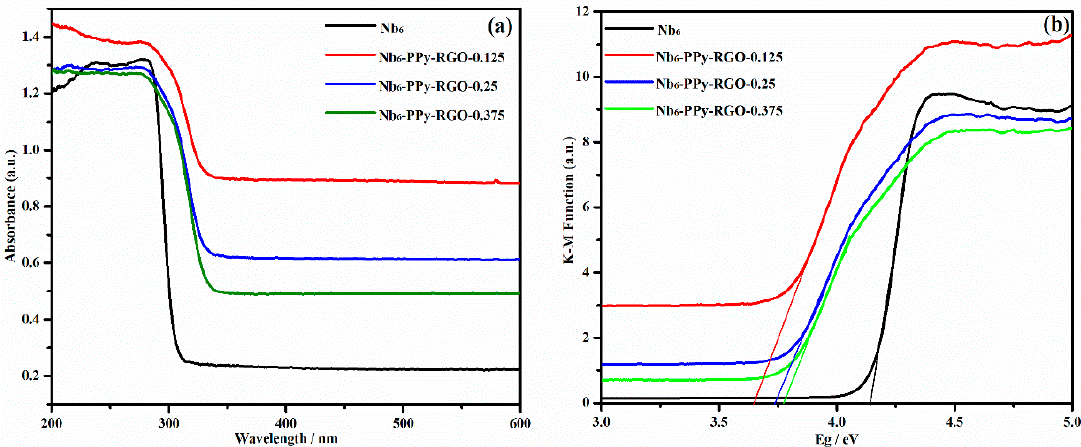
Figure 6. ( a ) UV-vis diffuses reflectance spectra of Nb 6 and Nb 6 /PPy-RGO composites; ( b ) Kubelka − Munk function-calculated band gap of Nb 6 and Nb 6 /PPy-RGO composites.